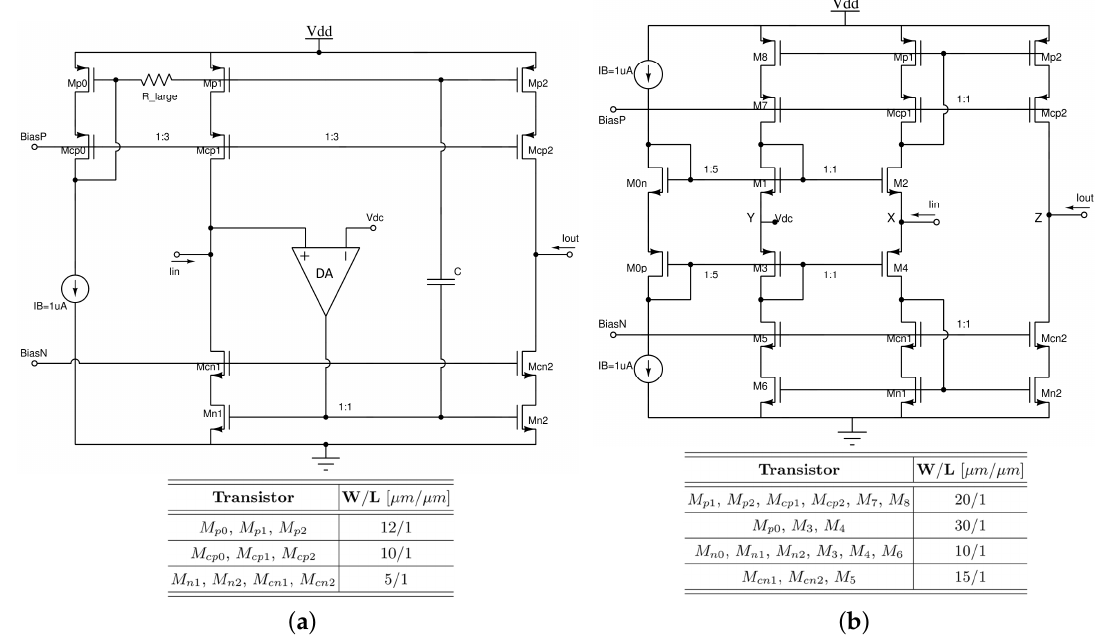
Figure 8. Class AB current buffers with a virtual ground at the input node and their transistor sizes: ( a ) QFG-CB; and ( b )